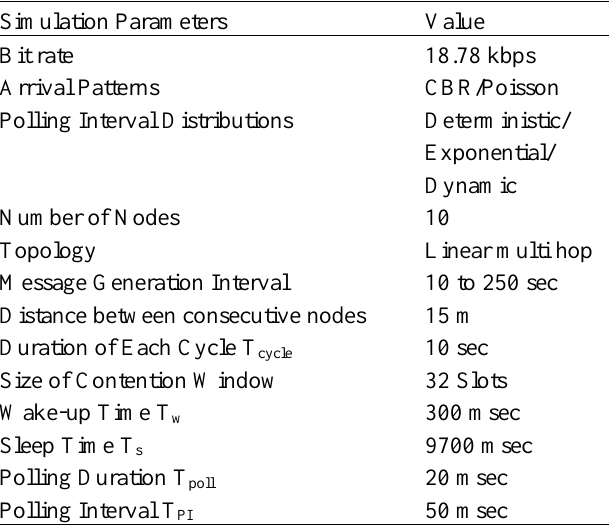
Simulation Settings for Comparing ADP-MAC with SCP-